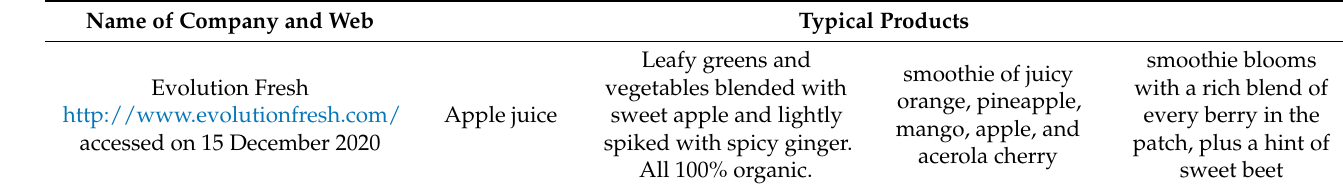
Table A6. High pressure treated products by the company Frubaca Cooperativa. Name of Company and Web Typical Products Frubaca Cooperativa de hortofruticultores, Crl. https://www.copa.pt/ accessed on 15 Decenber 2020 There are presented several juice combinations filled in 250 or 750 mL bottles: pure apple, orange, carrot and apple, orange and apple, pear and apple, pineapple and apple, strawberry and apple. Table A7. High pressure treated products by the company Giraffe (AJIZ Group Ltd.). Name of Company and Web